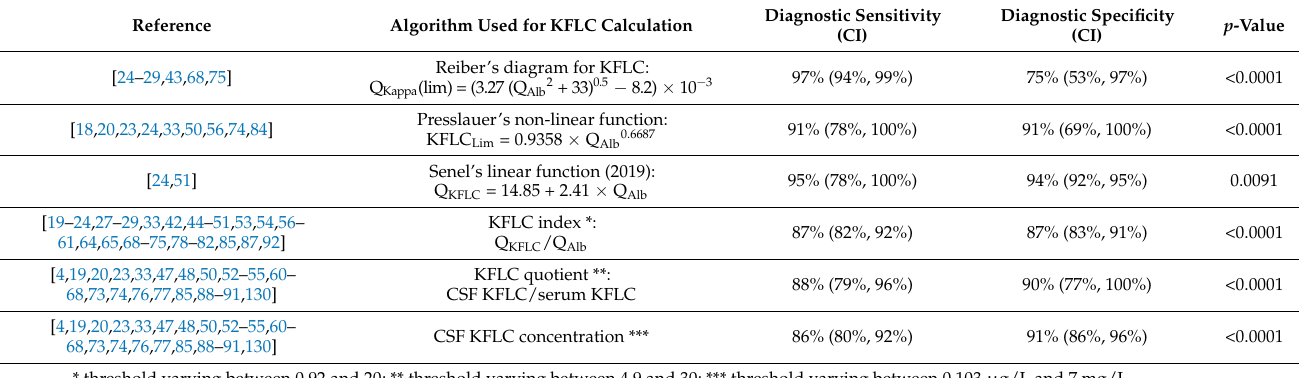
Table 2. Kappa free light chain (KFLC) threshold values in the diagnosis of